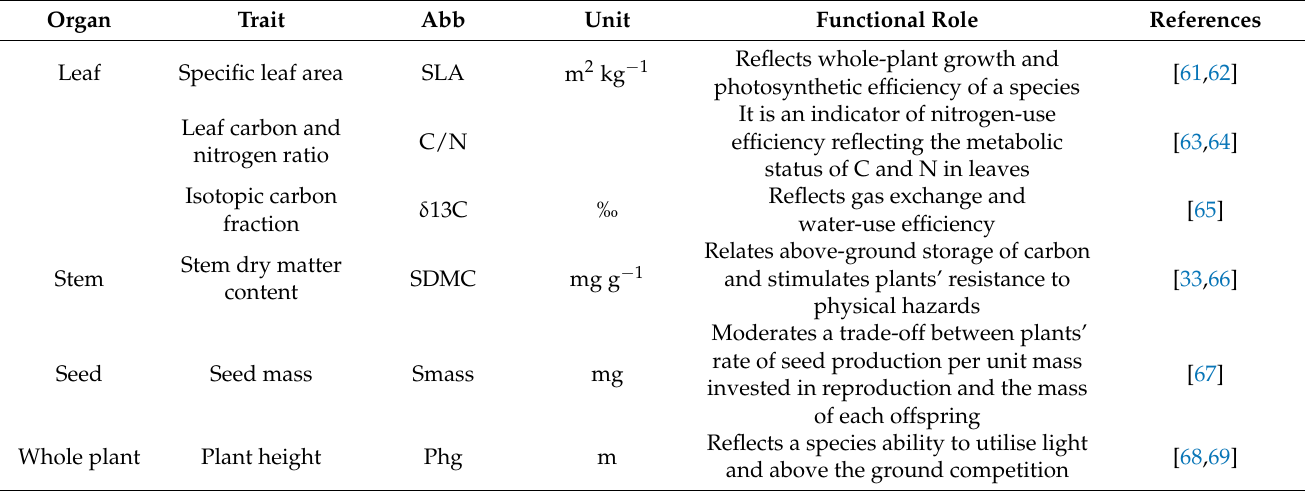
Table 1. Plant functional traits sampled and their respective functional roles in the